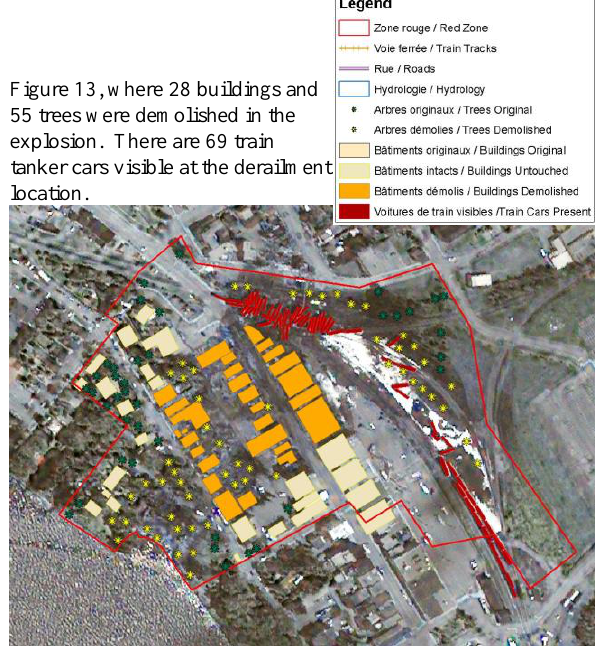
Figure 13. This QuickBird image acquired on July 7, 2013 has been vectorized with the changes to Lac-Mégantic after the disaster. © DigitalGlobe 2012